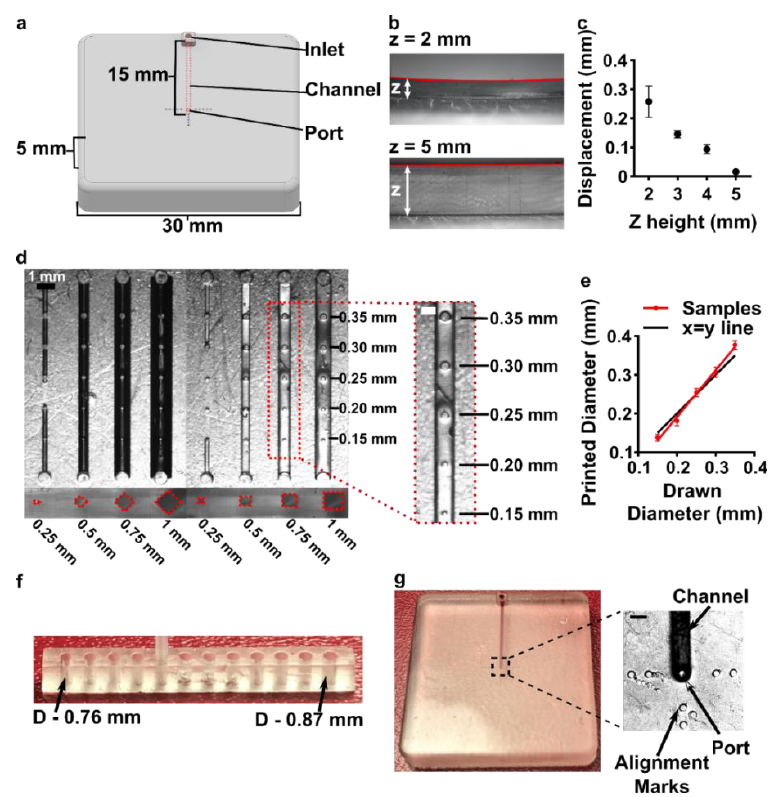
Figure 3. Optimization of the printability of the delivery component of the movable port device. ( a ) AutoCAD inventor drawing of the delivery component. ( b , c ) Print warping was minimized by increasing the thickness (z) of the print, analyzed from size-view images ( b ) and quantified in ( c ) as the measured displacement of the center of the print from horizontal (mean ± Std Dev, n = 3). ( d ) A top-down image of a printed test piece that was used to determine minimum printable channel and port dimensions. Channel side length varied from 0.25 to 1 mm; cross-sectional shape was diamond or square. The top of each channel included printed ports of 0.15 to 0.35 mm diameter, shown in the inset. ( e ) Printed diameter of port versus drawn dimension (mean ± Std Dev, n = 8); linear fit yielded y = 1.2x − 51. The black line shows y = x, for reference. ( f ) A test piece used to optimize the inlet connection to fit a PTFE tubing with the tightest connection. ( g ) Image of the optimized delivery component, with the channel filled with red food dye. Inset shows a micrograph of the delivery port with alignment markers. Scale bar 0.5